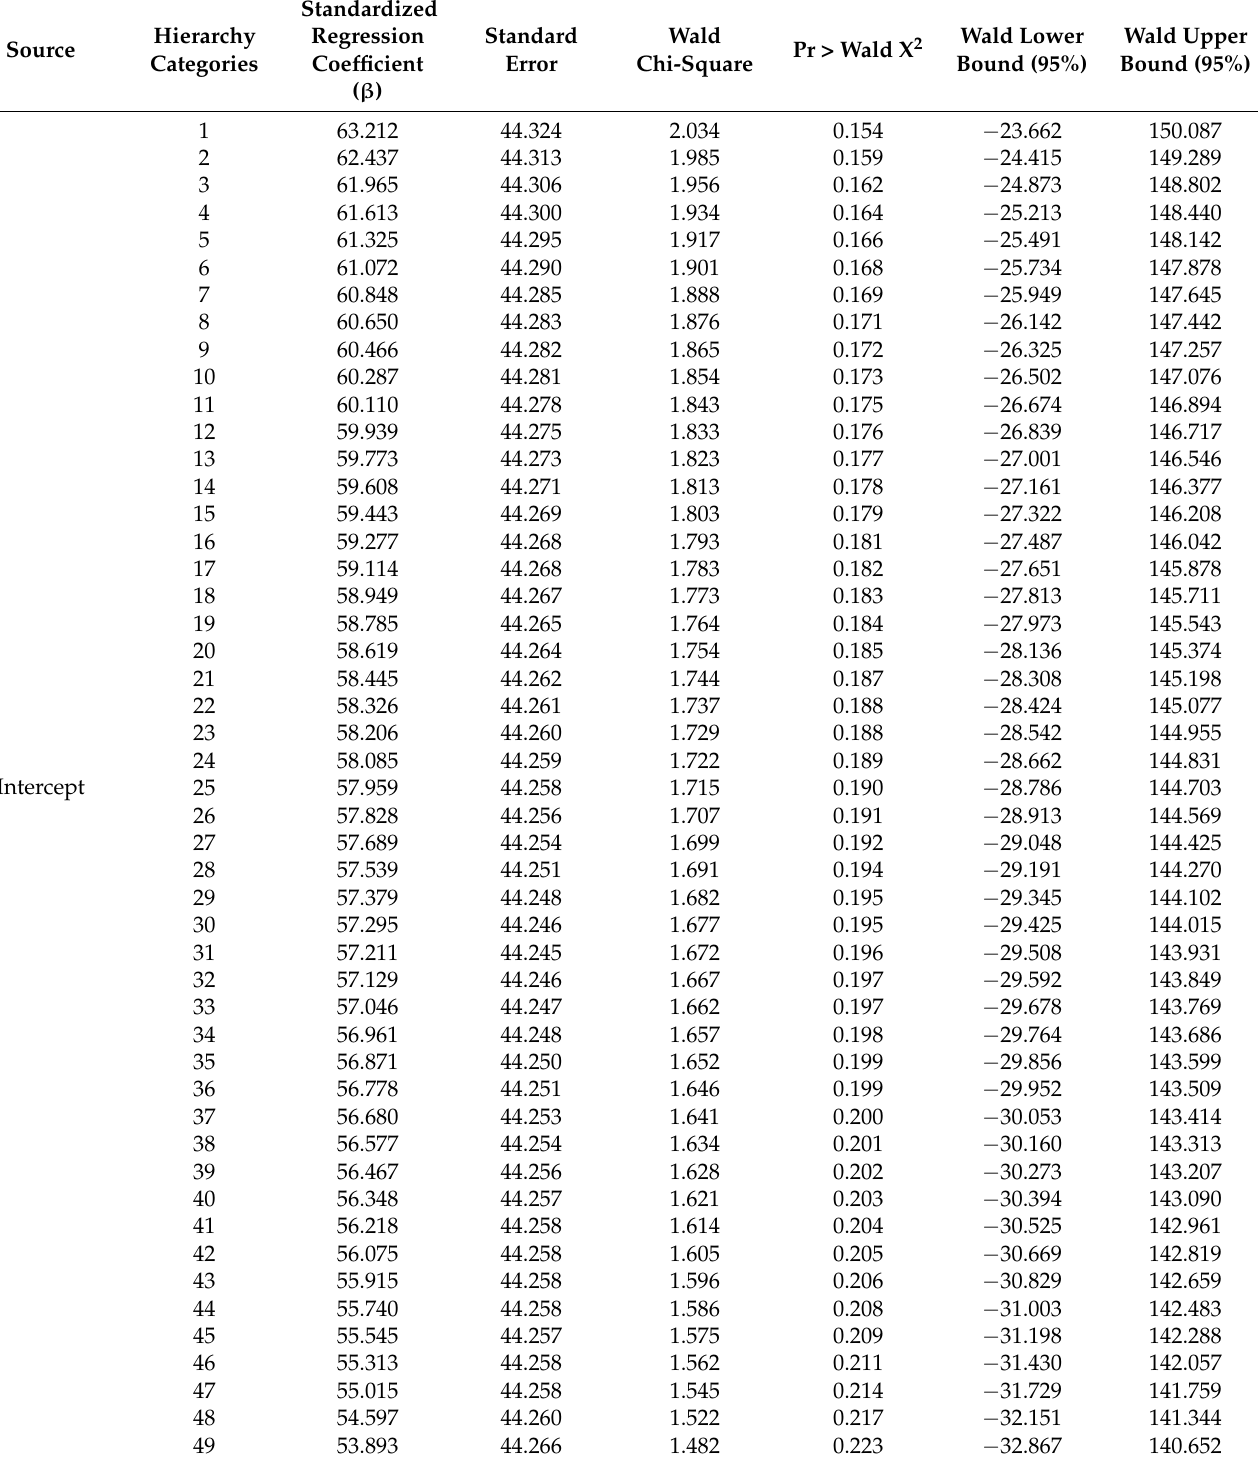
Table 3. Standardized regression coefficients for the factors and covariates considered in the model for the intraherd hierarchy